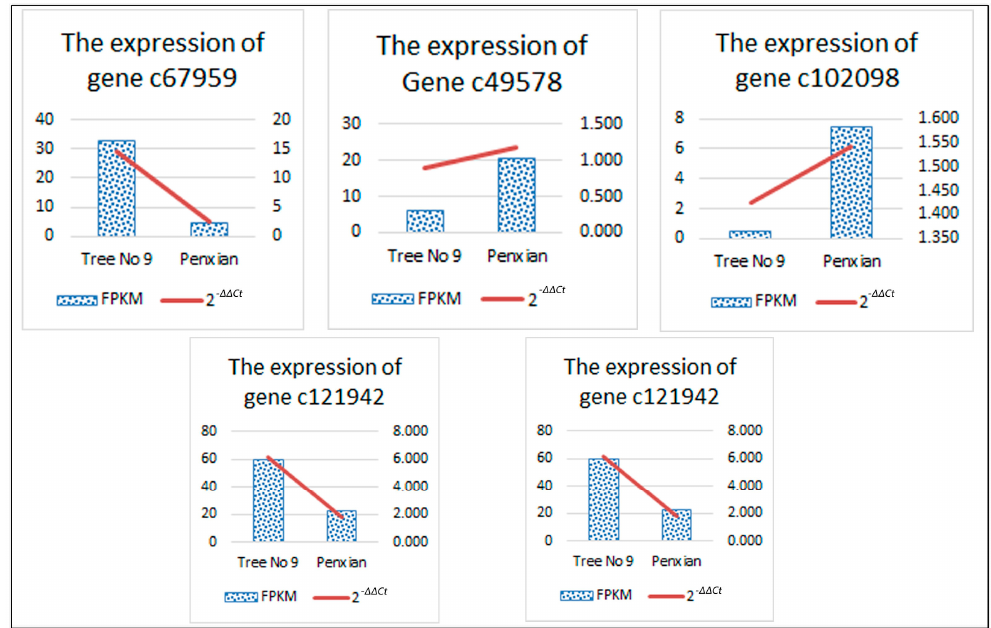
Figure 8. The expression of each gene by RT-qPCT and RNA-Seq.